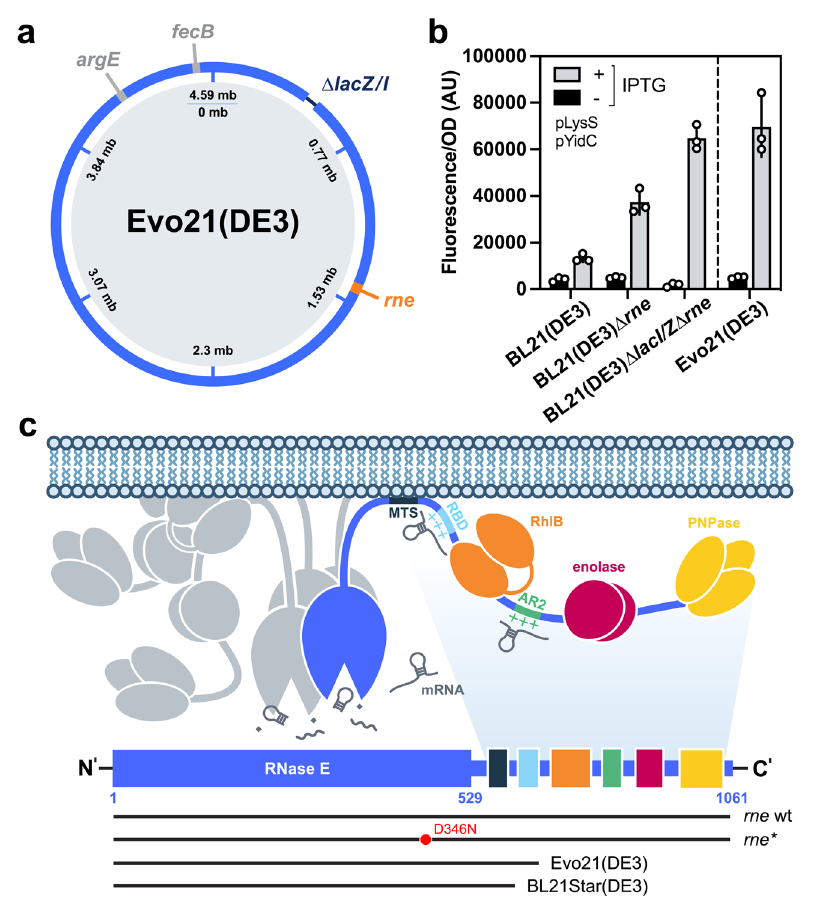
Fig. 3 Identi fi cation of an RNase E mutation in Evo(DE3) causative for tolerance towards toxic protein production. a Illustration of mutations in the Evo21(DE3) genome compared to the ancestor BL21(DE3). Whole-genome sequencing of mutant strain Evo21(DE3) revealed two point mutations (grey) and a truncation of the rne gene caused by the transposition of a mobile element IS1 into the locus. The deletion of the genomically shared homology sequence in the BL21(DE3) ancestor strain with the λ DE3 area (335,401 – 337,123) is annotated. b Production levels of the toxic YidC-GFP-fusion protein in Evo21(DE3) compared to BL21(DE3), as well as BL21(DE3) and the non-evolved ancestor strain BL21(DE3) Δ lacI Δ lacZ after reintroducing the rne truncation by recombineering. Error bars indicated represent the average squared deviation from the mean (SD) of three biologically independent samples ( n = 3). c Illustration of the E. coli RNA degradosome. N- and C-terminal domain of the membrane-bound essential endonuclease RNase E (blue) and the localisation of associated enzymes PNPase, Rhlb and enolase along the C-terminal non-catalytic scaffolding region are displayed. Mutations of the rne gene in Evo21(DE3), BL21Star(DE3) and rne* gene harboured on pLysS-Max are